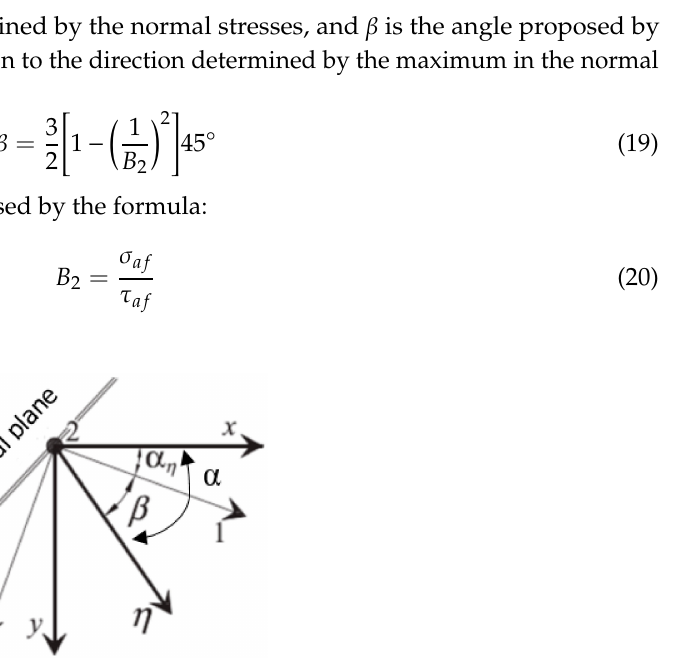
Figure 3. Graphical interpretation of the angle β